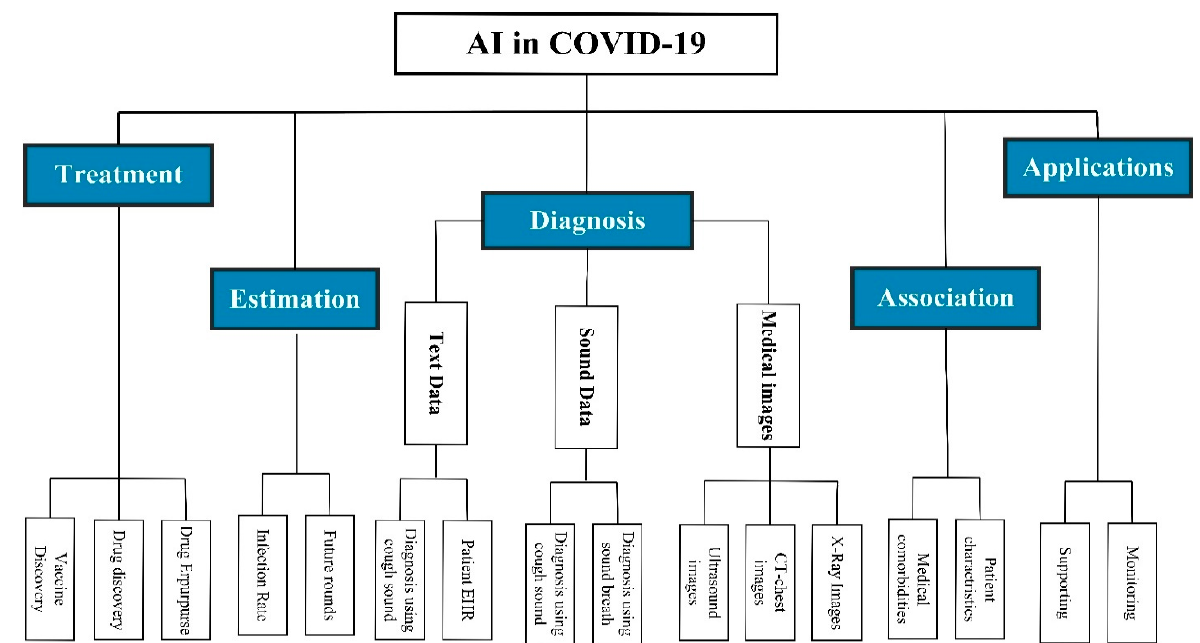
Figure 1. Taxonomy of using AI in COVID-19.